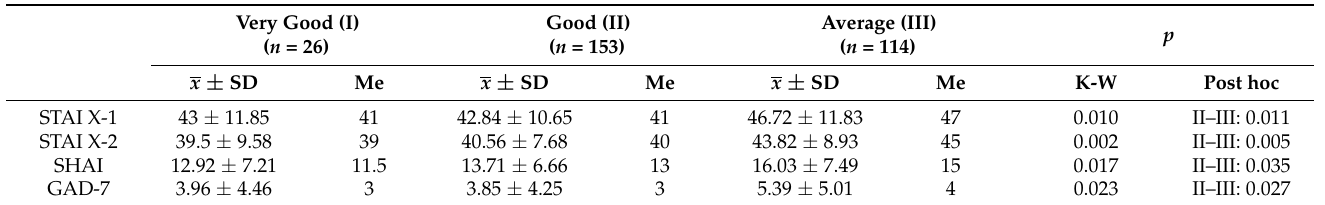
Table 6. Impact of financial status on the scores obtained in the psychometric scales applied in the study *. Very Good (I) ( n = 26)